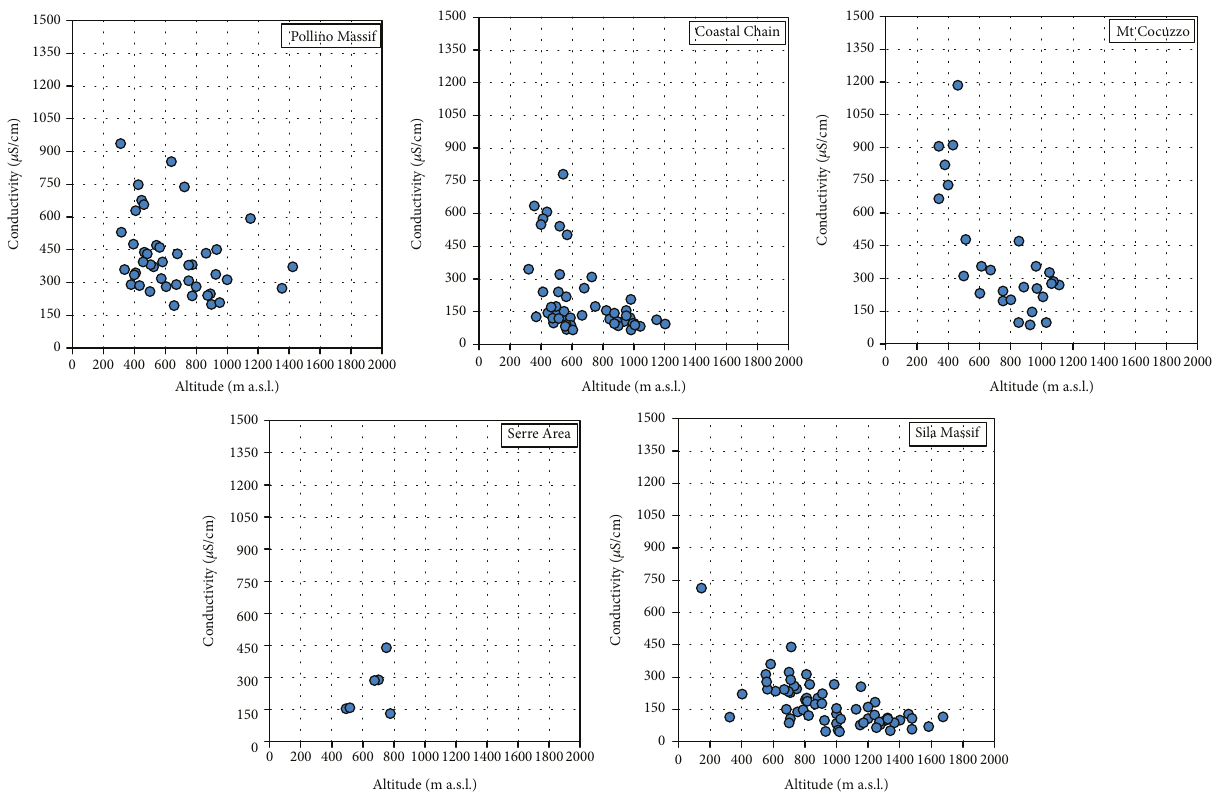
Figure 3: Relationship between spring water EC and